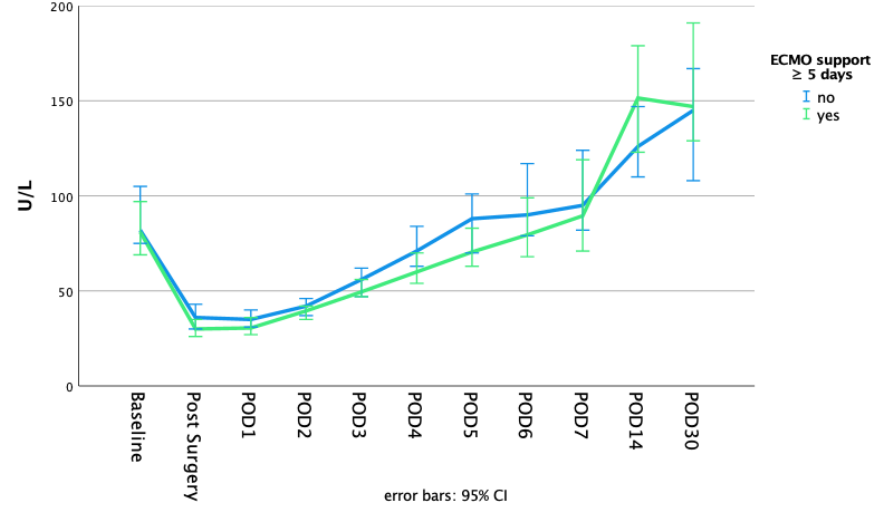
Figure 2. Alkaline phosphatase blood values dependent on the ECMO duration at the baseline on each consecutive day until POD 7, as well as on POD 14 and POD 30.